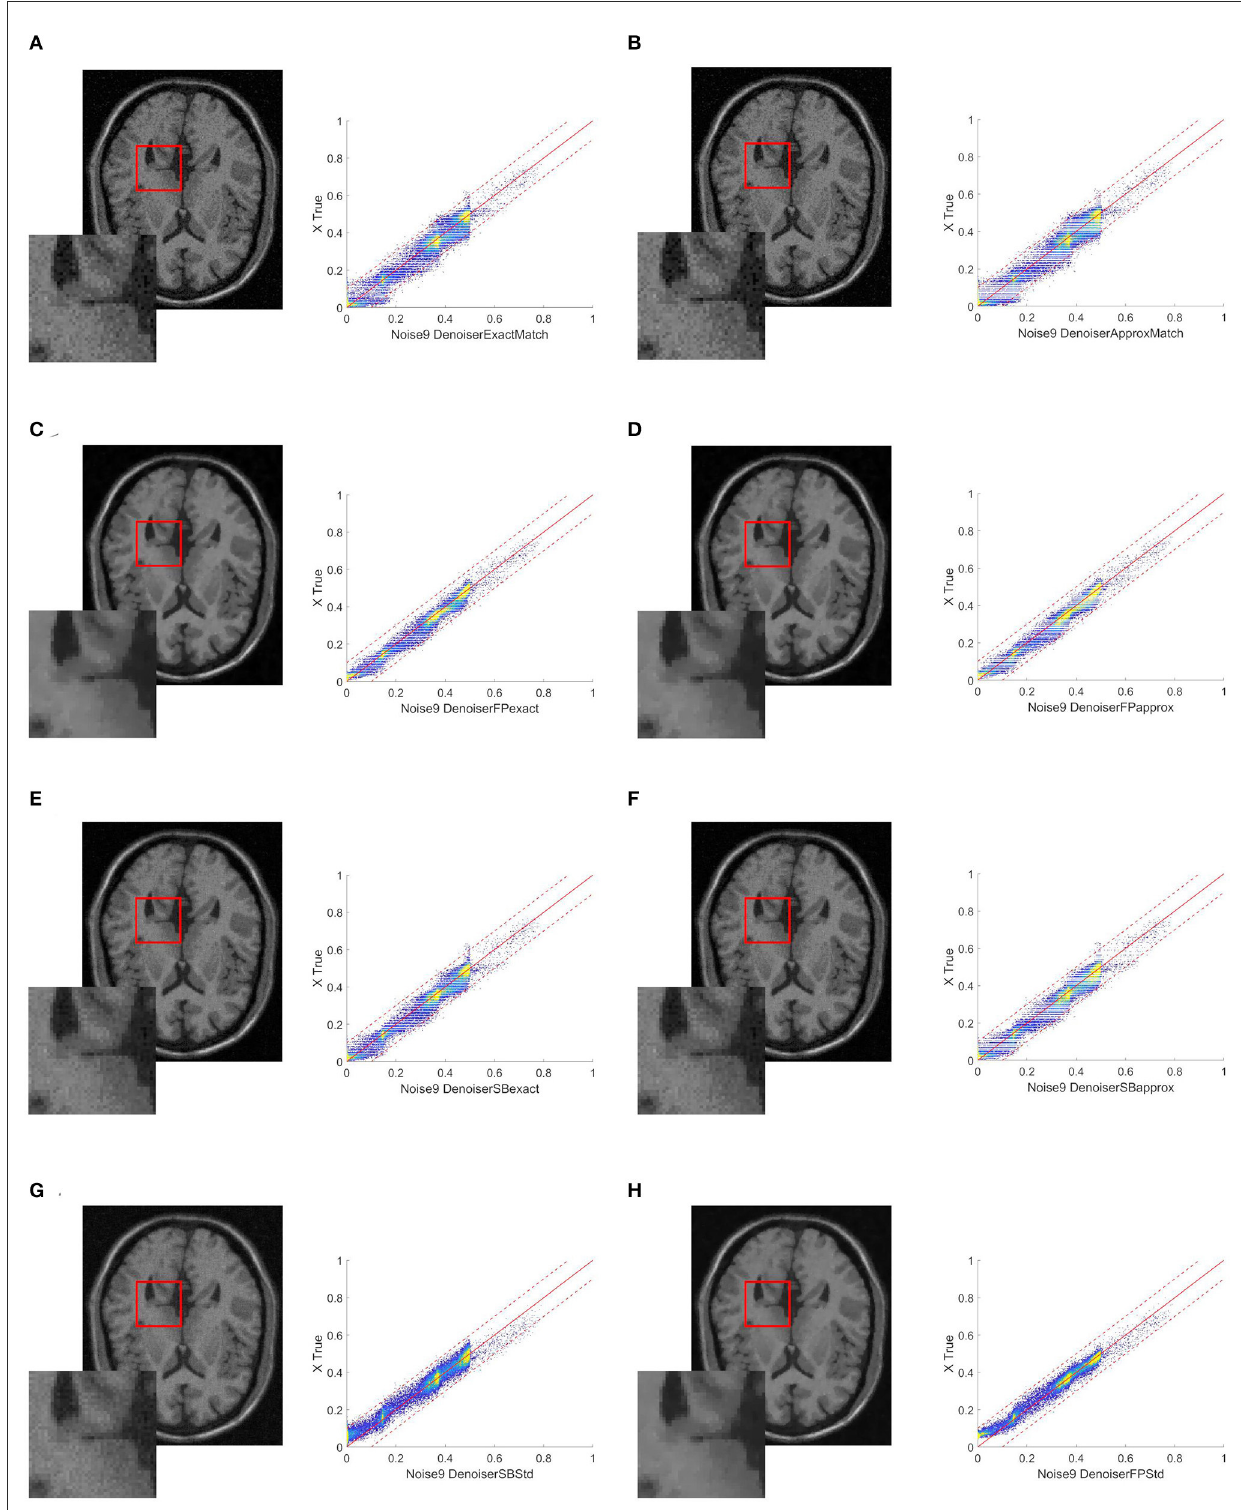
FIGURE4 Resulting images when the target image is collected at a distance of +5 mm from the references, also with 3% noise. (A) ExactMatch and (B) ApproxMatch applied to the image with 9 % noise. (C) FP exact and (D) FP approx denoiser applied to the image with 9 % noise. (E) SB exact and (F) SB approx applied to the image with 9 % noise. (G) SB standard and (H) FP standard applied to the image with 9 %